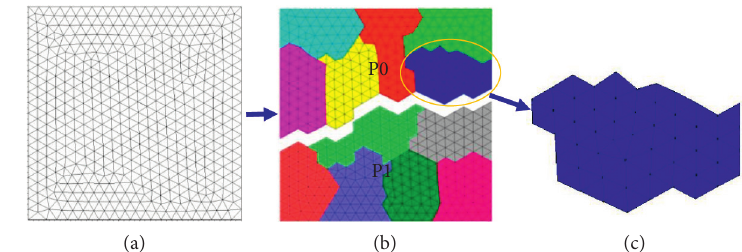
Figure 2: A two-level partitioning strategy in the JAUMIN framework.